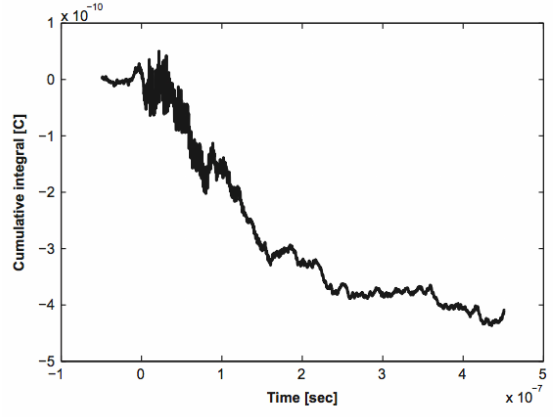
Figure 13. The cumulative integration of the FC